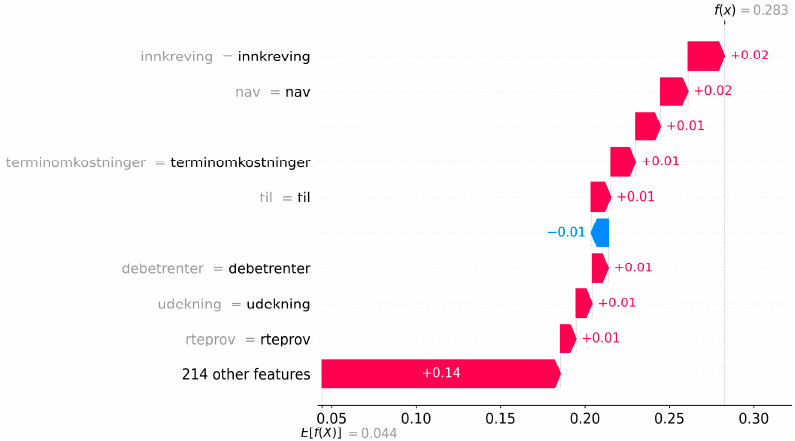
Figure 7. Local explainability, case 2. Words that contribute the most to